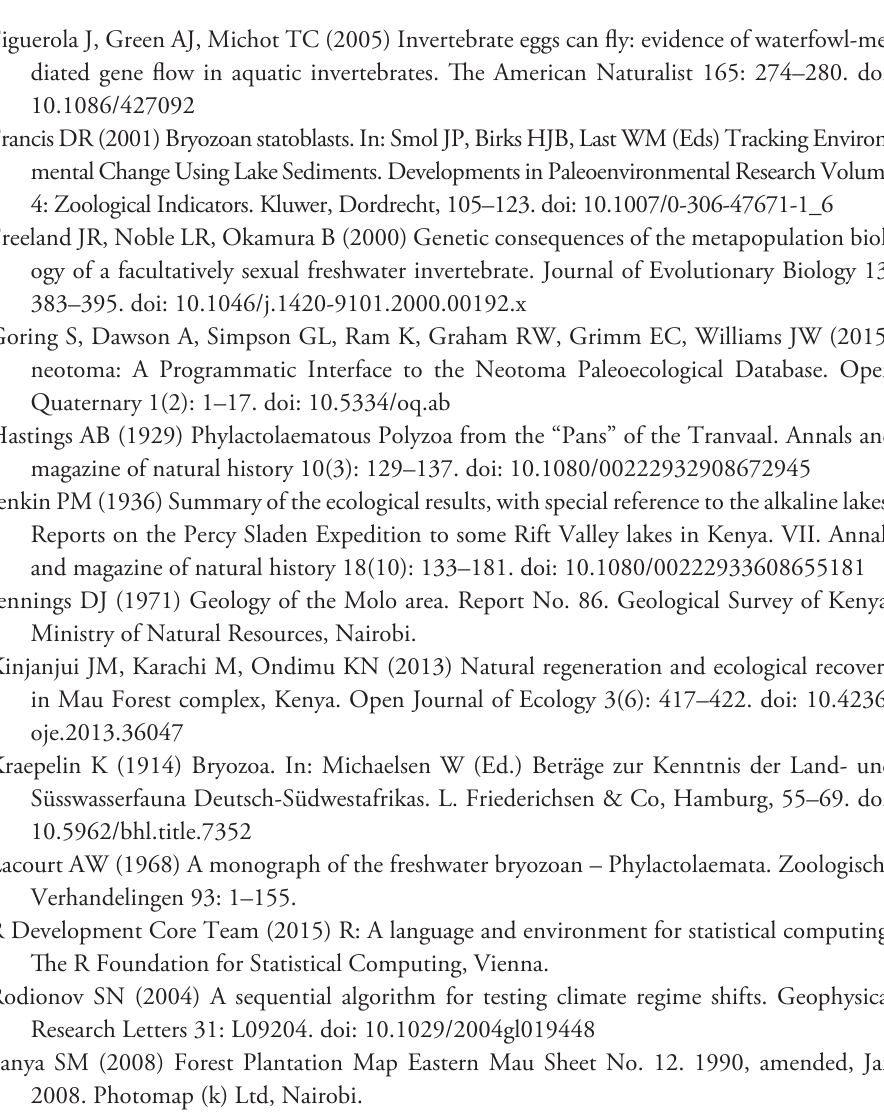
Figuerola J, Green AJ, Michot TC (2005) Invertebrate eggs can fly: evidence of